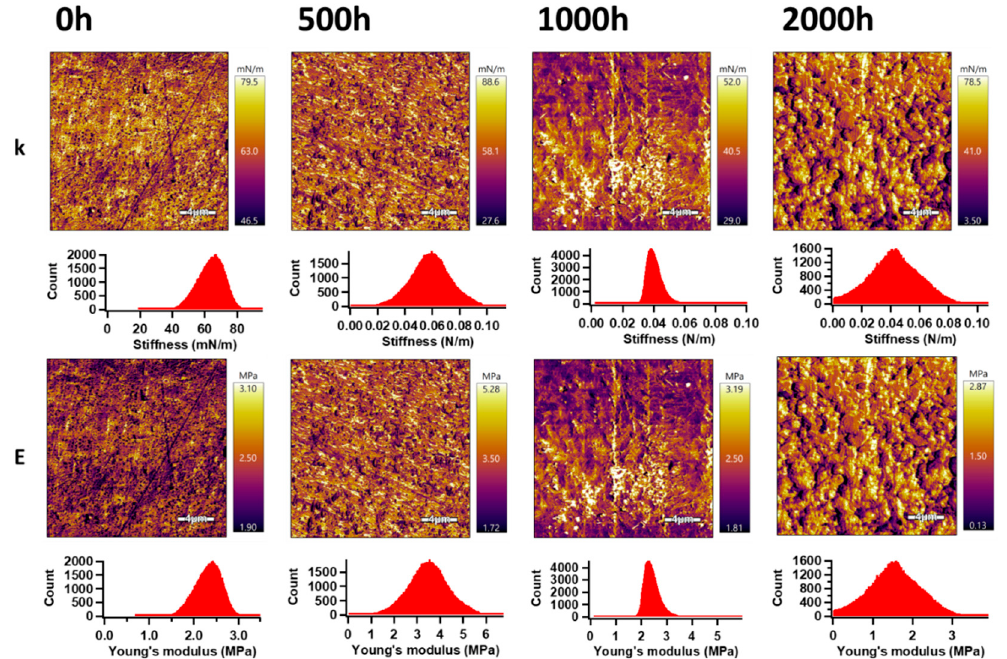
Figure 12. AM–FM images and histograms of the PHBV/TiO 2 samples before and after the accelerated weathering; k and E represent the stiffness and Young’s modulus, respectively.